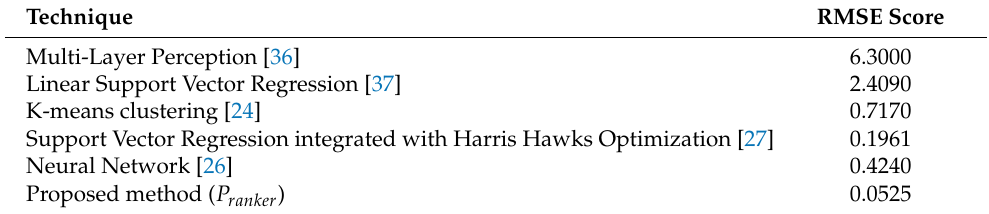
Table 3. Performance comparison of proposed methodology with state-of-the-art